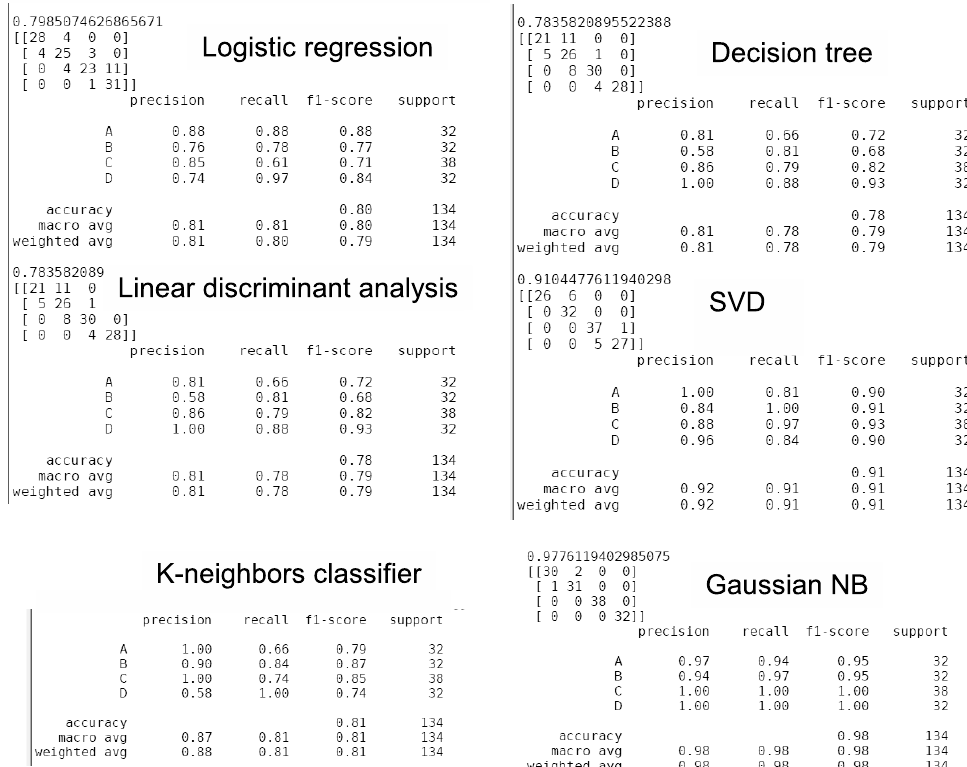
Figure 9. Results of the classification algorithm considered in the second approach.